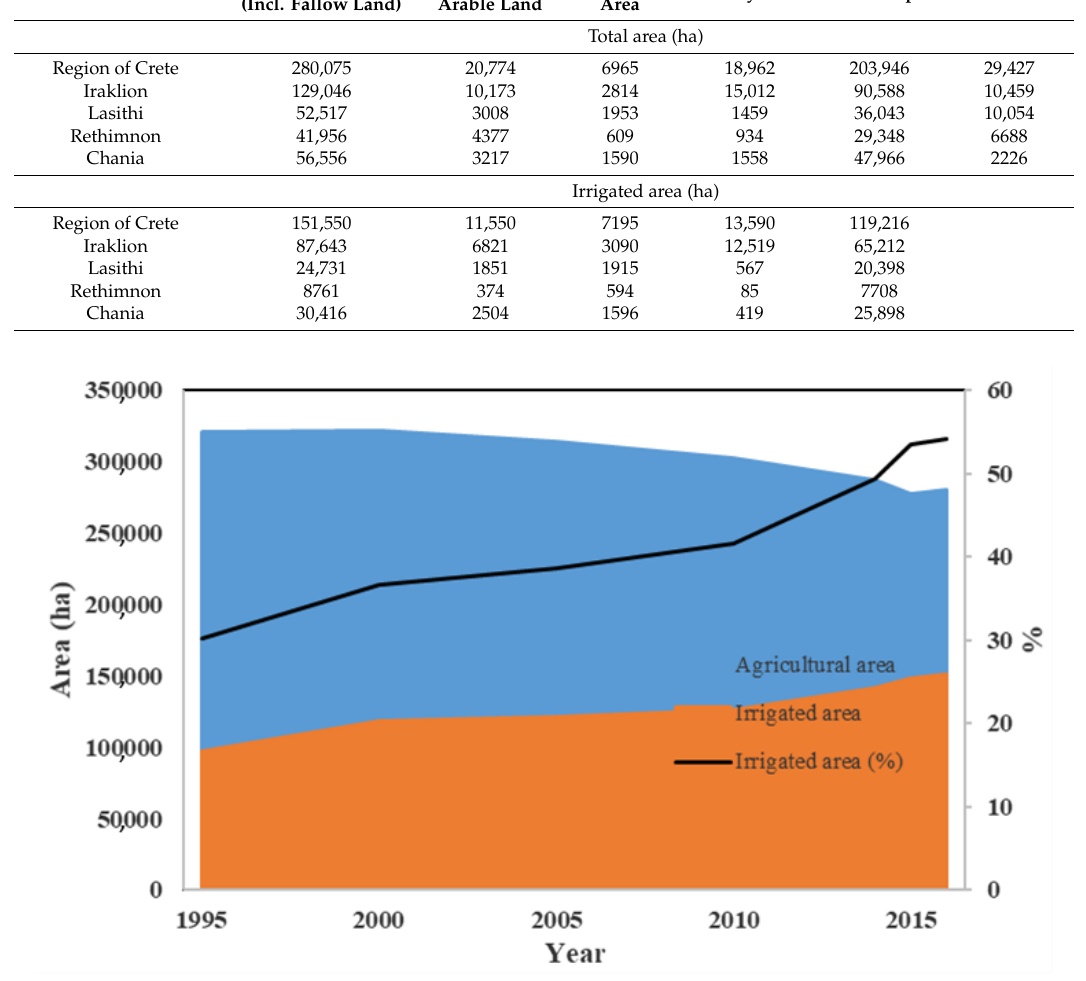
Figure 7. Change of the irrigated area from 1995 until the present (modified from [65]) .